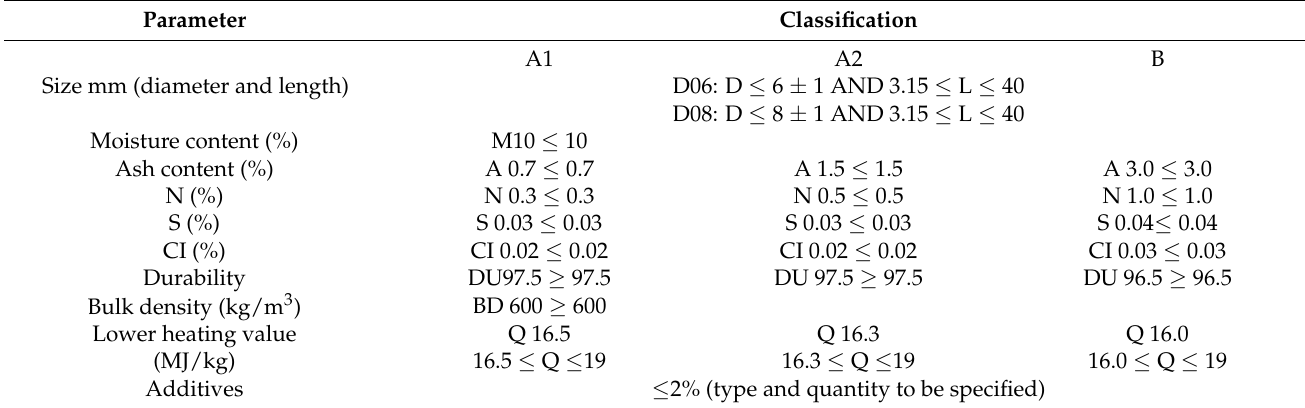
Table 2. European Standard EN 14961-2 to produce non-industrial